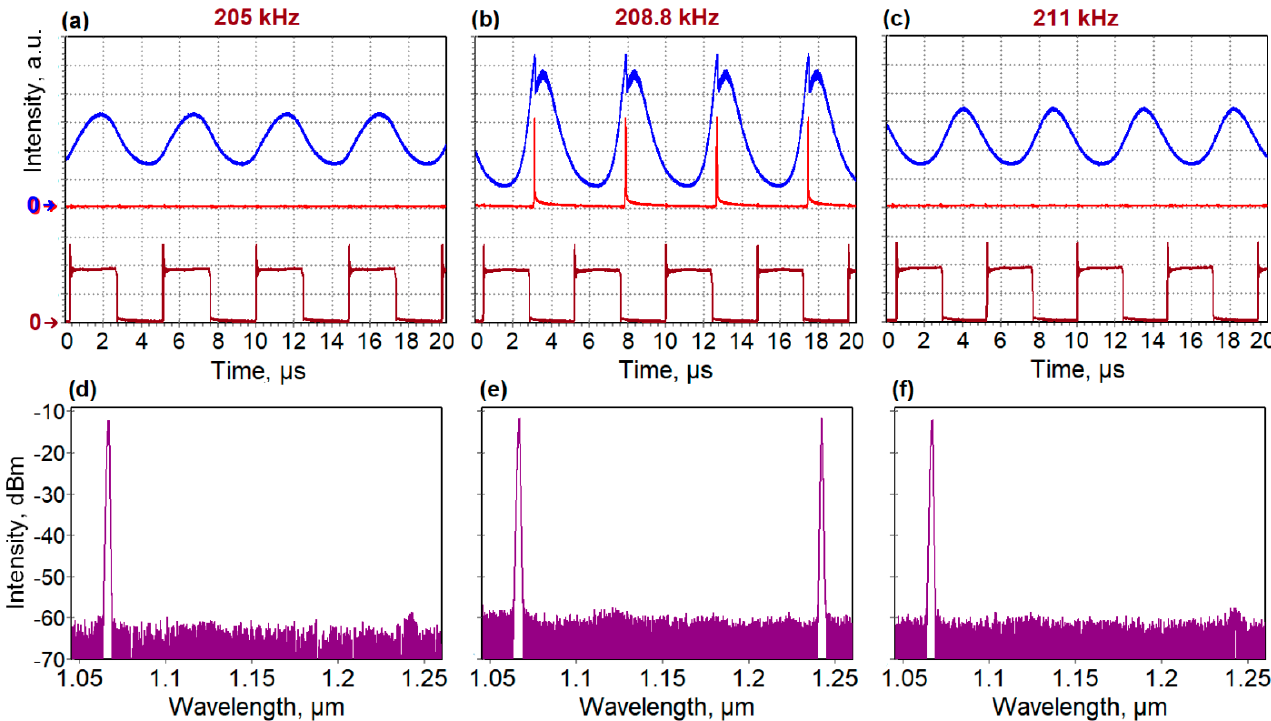
Figure 4. Dependence of the average output power at each lasing wavelength (1.07 µ m and 1.24 µ m) on the modulation frequency of the quasi-synchronous pumping.